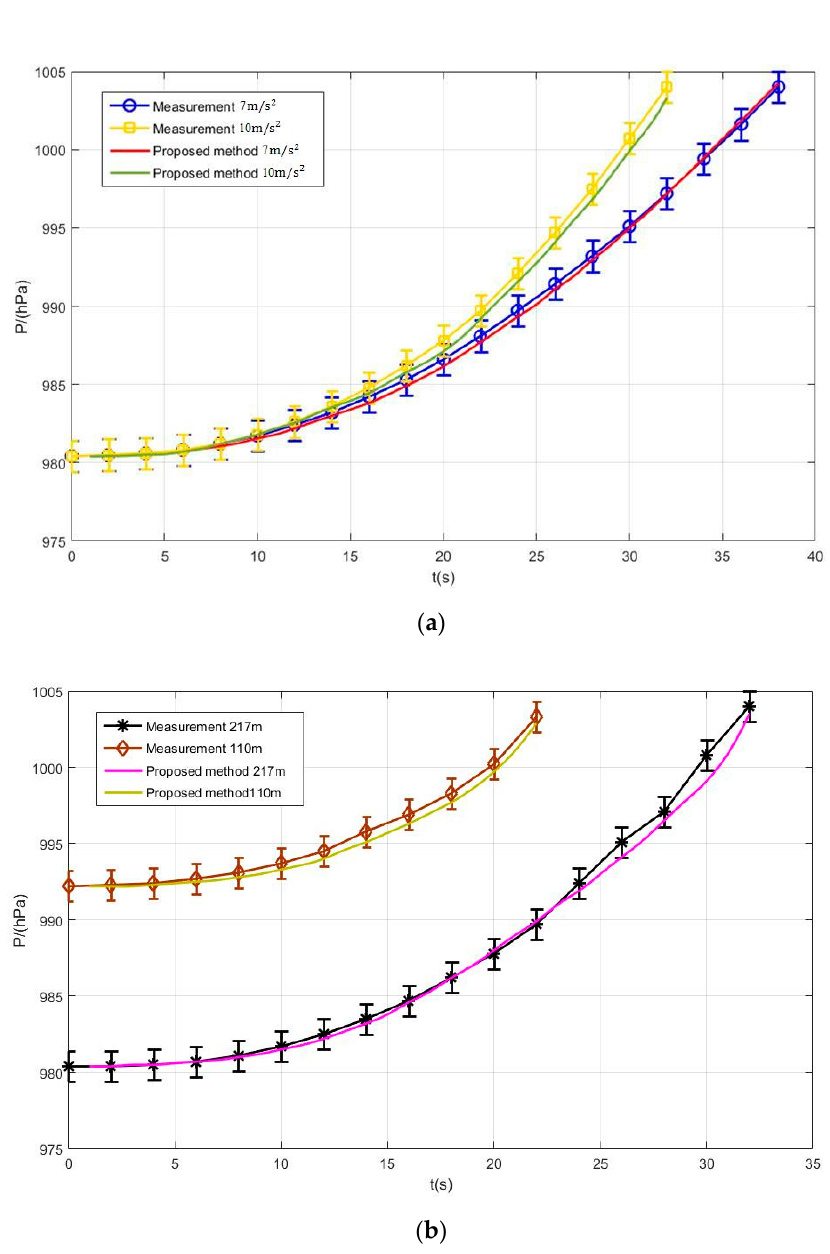
Figure 10. Air pressure value curves (measured by experiments) inside the elevator car. ( a ) At the same height ( 𝐻 (cid:3404) 217 m ) and different speeds; and ( b ) at the same speed ( 𝑣 (cid:3404) 10 m/s ) and different heights. the same height ( H = 217 m) and different speeds; and ( b ) at the same speed ( v = 10m/s) and different